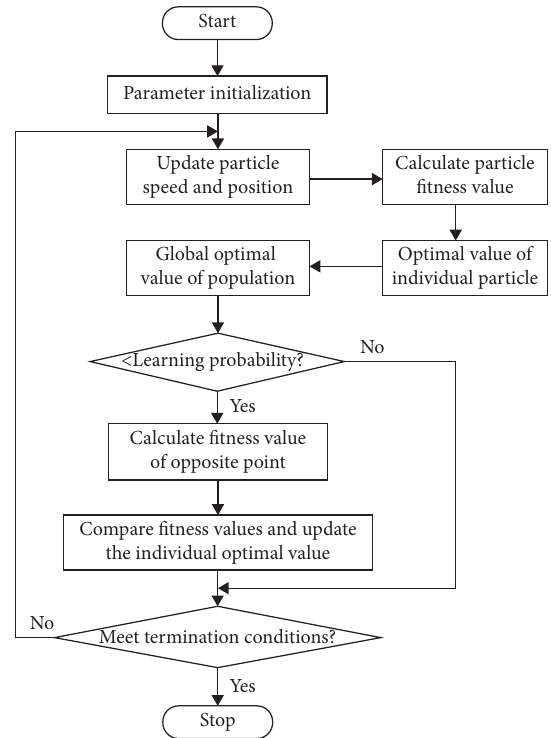
Figure 2: MPSO with learning